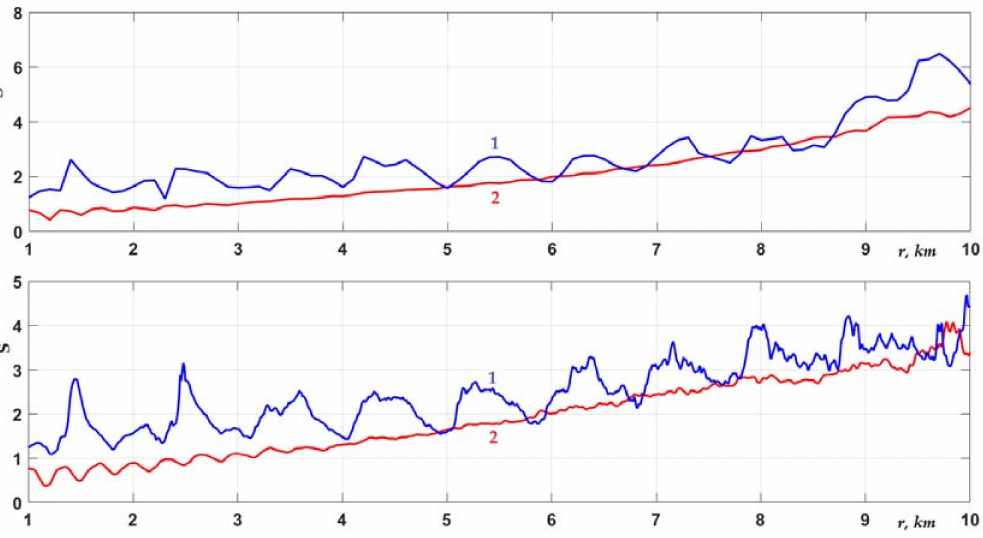
Figure 10. Behavior of the scintillation index of a signal of 250 Hz in a waveguide with fluctuations both in the sediments δ c 1 and the bathymetry δ h . L rc = 1 km; c = (cid:104) c 1 (cid:105) = 1460 m/s. Top graph corresponds to L h = 1 km; curves: 1 is OW solution, z = z 0 = 36 m, 2 is for z = z 0 = 24 m. Lower graph corresponds to L h = 100 m; curves: 1 is OW solution, z = z 0 = 36 m, 2 is for z = z 0 = 24 m.